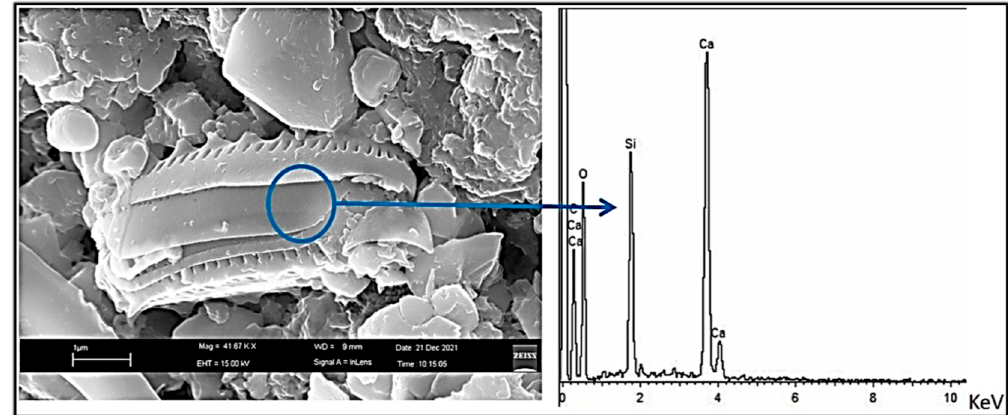
Figure 10. SEM image and associated EDS spectrum of microalgae (diatoms) on the wall.